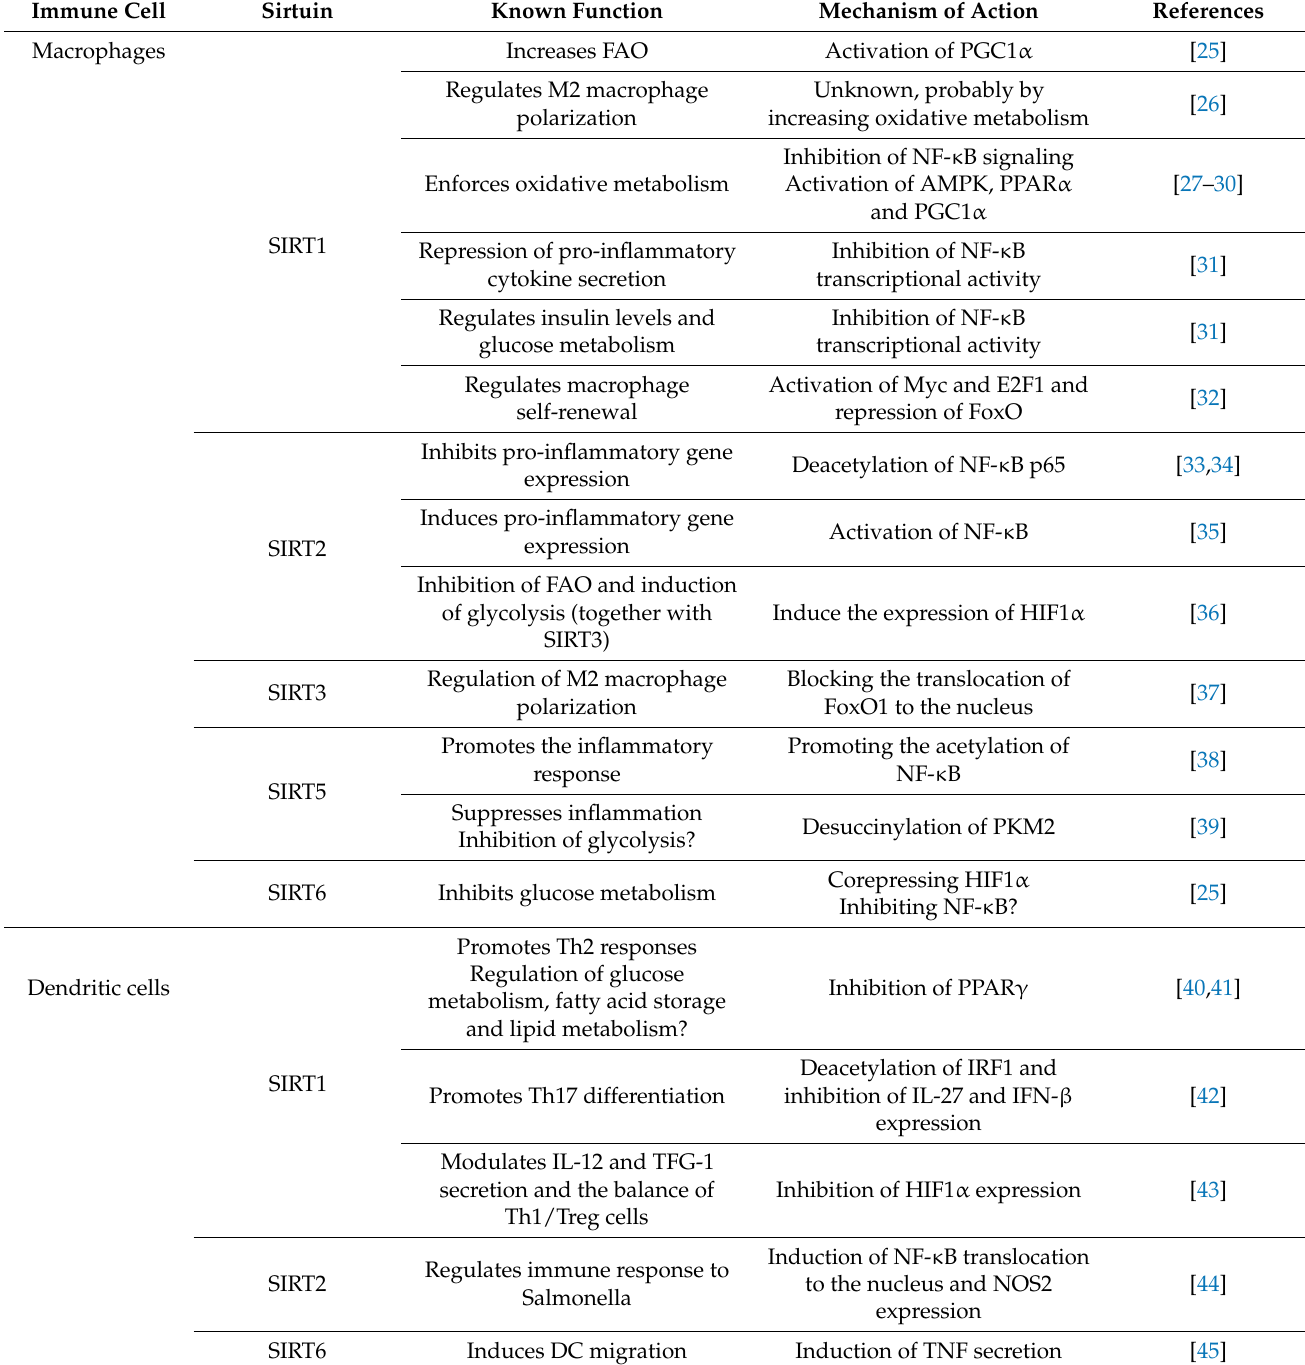
Table 1. Summary of main functions and metabolic pathways regulated by sirtuins in immune cells. Immune